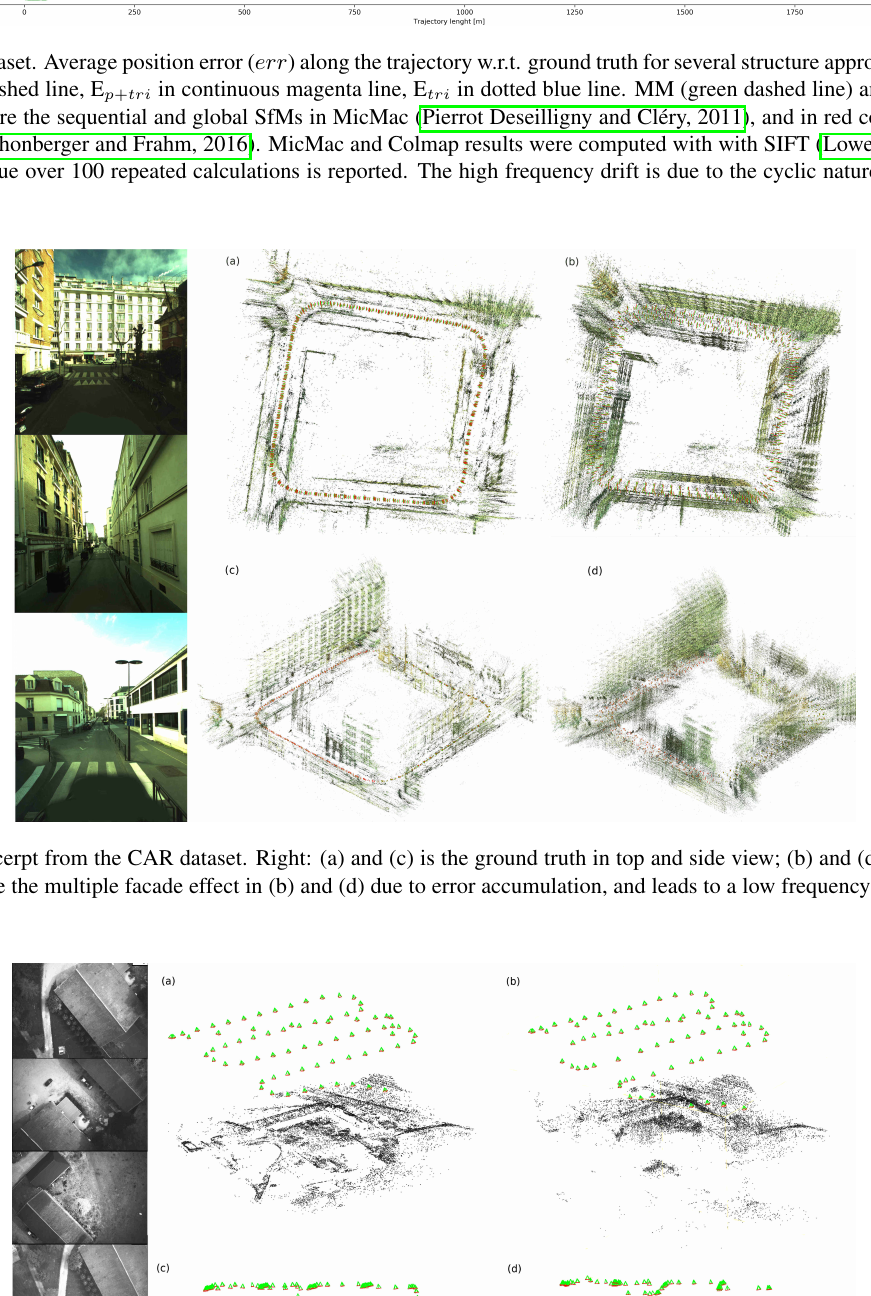
This contribution has been peer-reviewed. The double-blind peer-review was conducted on the basis of the full paper. https://doi.org/10.5194/isprs-annals-V-2-2020-71-2020 | © Authors 2020. CC BY 4.0